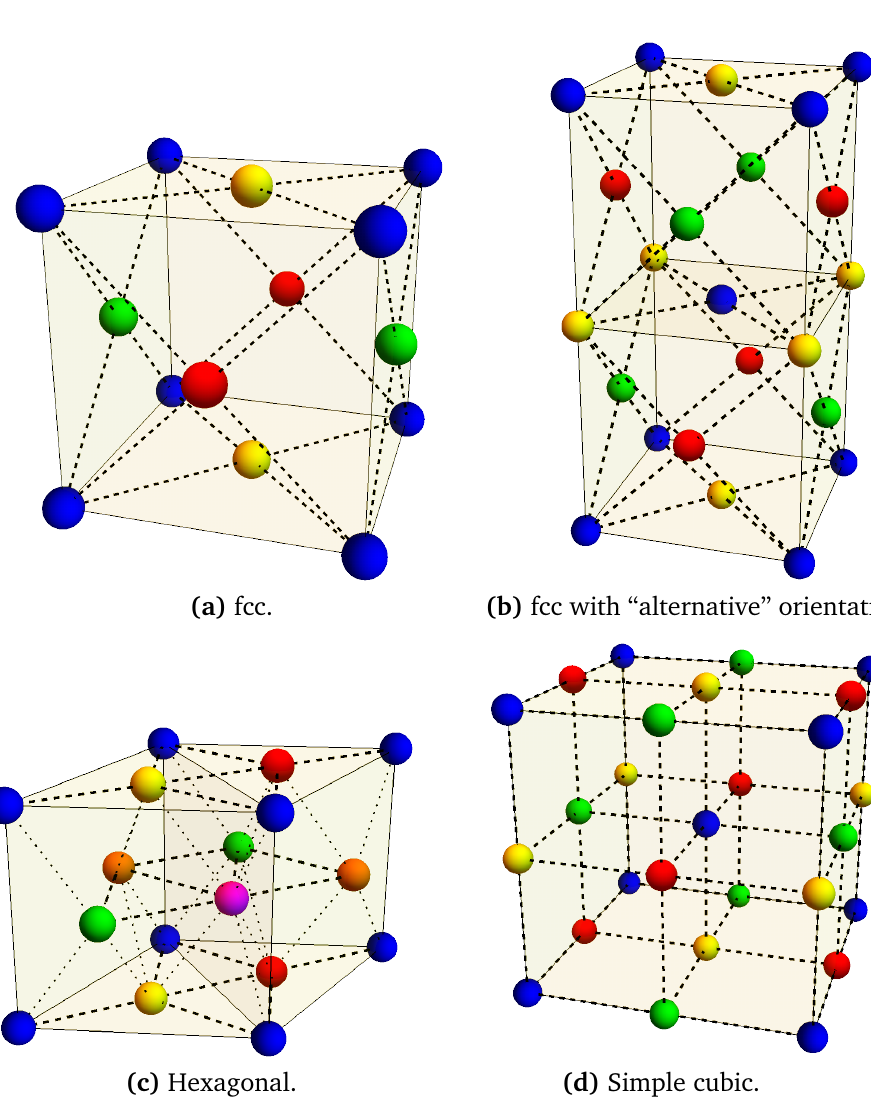
Figure 9: The unit cells of the non-Abelian crystals. The crystal structures are the fol- lowing: (a) Tetragonal / cubic (fcc) lattices with “standard” orientation pattern. (b) Tetragonal / cubic (fcc) lattices with “alternative” orientation pattern. (c) Hexagonal lattices (including hcp). (c) Simple tetragonal / cubic lattices. We show the results for the standard aspect ratio, i.e., c = 1 for the crystals (a), (b) and (d) so that the (cid:112) lattices are exactly cubic, and c = 2 2 / 3 for the hexagonal case so that the lattice is hcp, but all crystals also appear with other values of the aspect ratio in the final phase diagrams. For the cubic lattices (a), (b) and (d) blue, green, red, and yellow colors stand for the orientations 1, i , j , and k , respectively. For the six orientations in the hexagonal case (c) , see